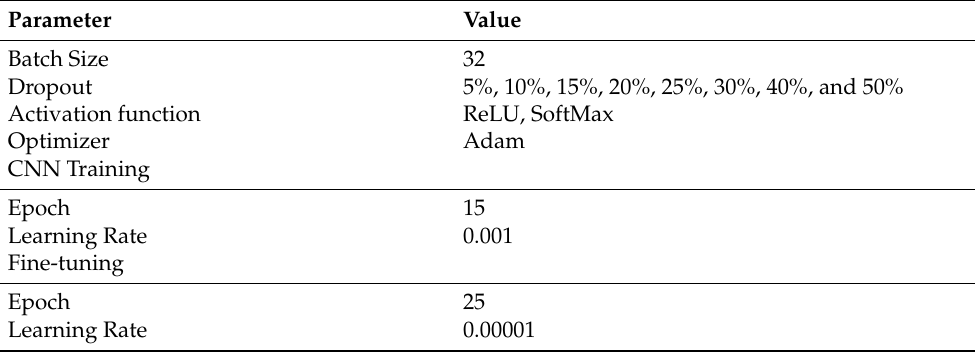
Table 3. Parameters value used to build tomato disease diagnosis models for the CNN training and fine-tuning phases.